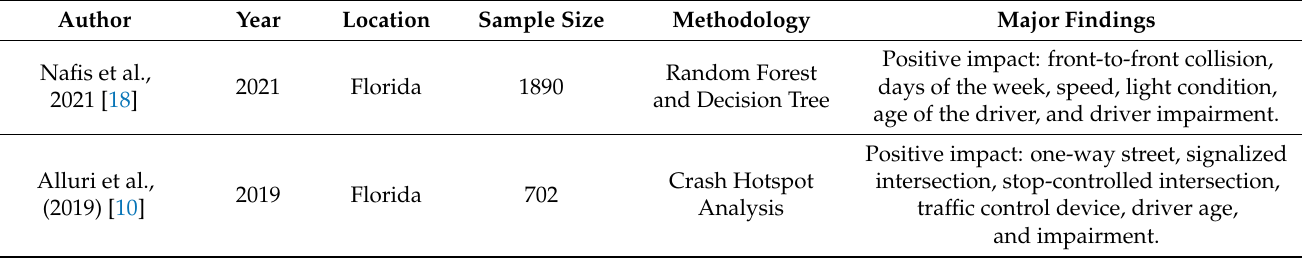
Table 1. Summary of Literature on WWD